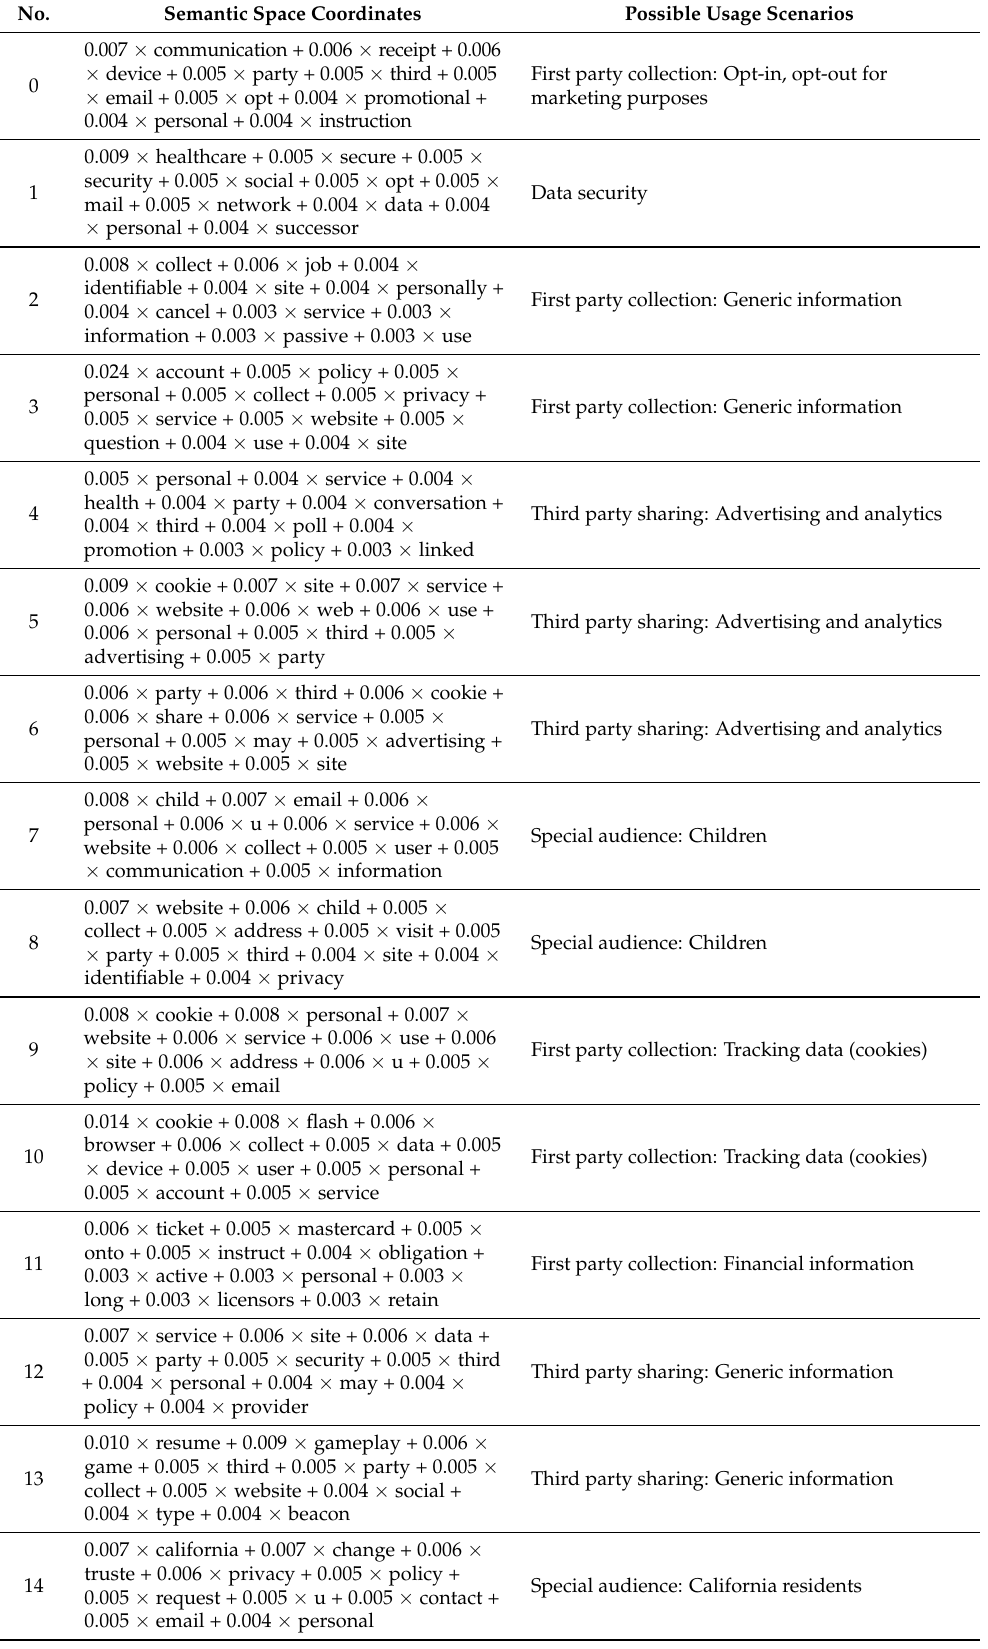
Table 3. Results of topic modeling for the OPP-115